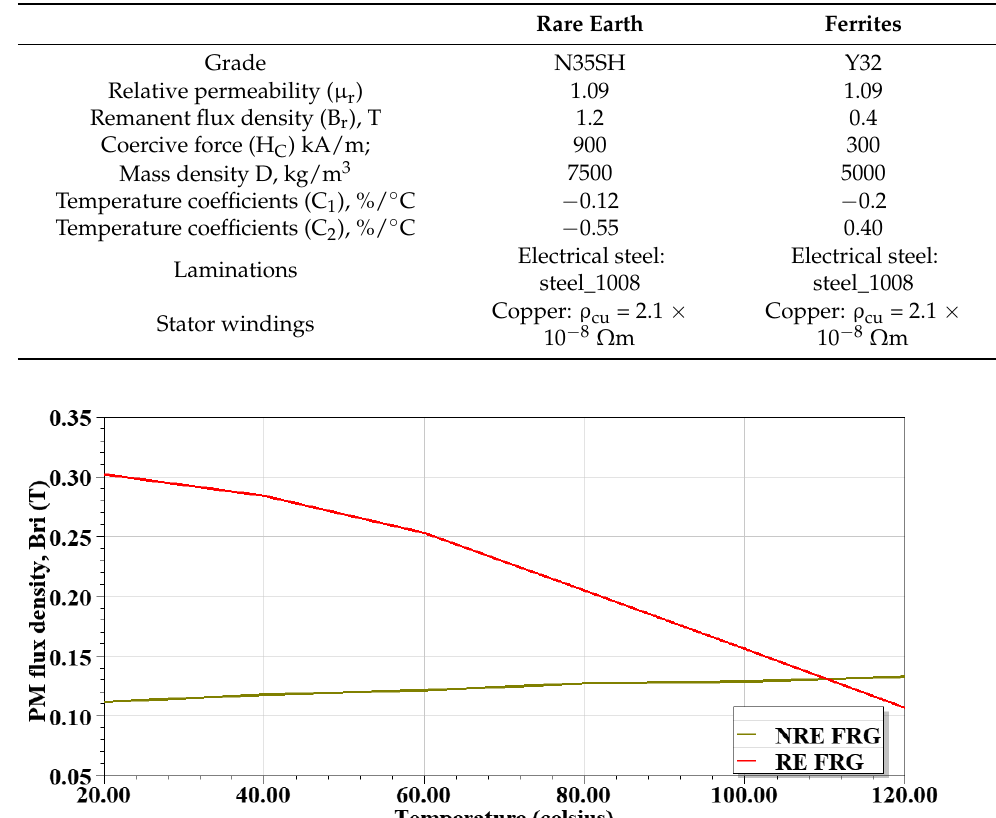
Table 5. Material specifications.